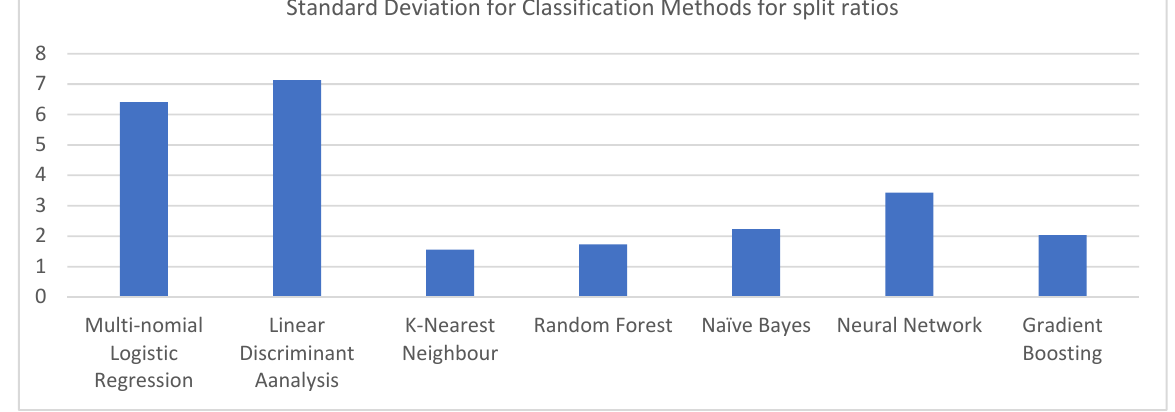
Figure 3. Standard deviation of accuracy of different classification methods for different split ratios.